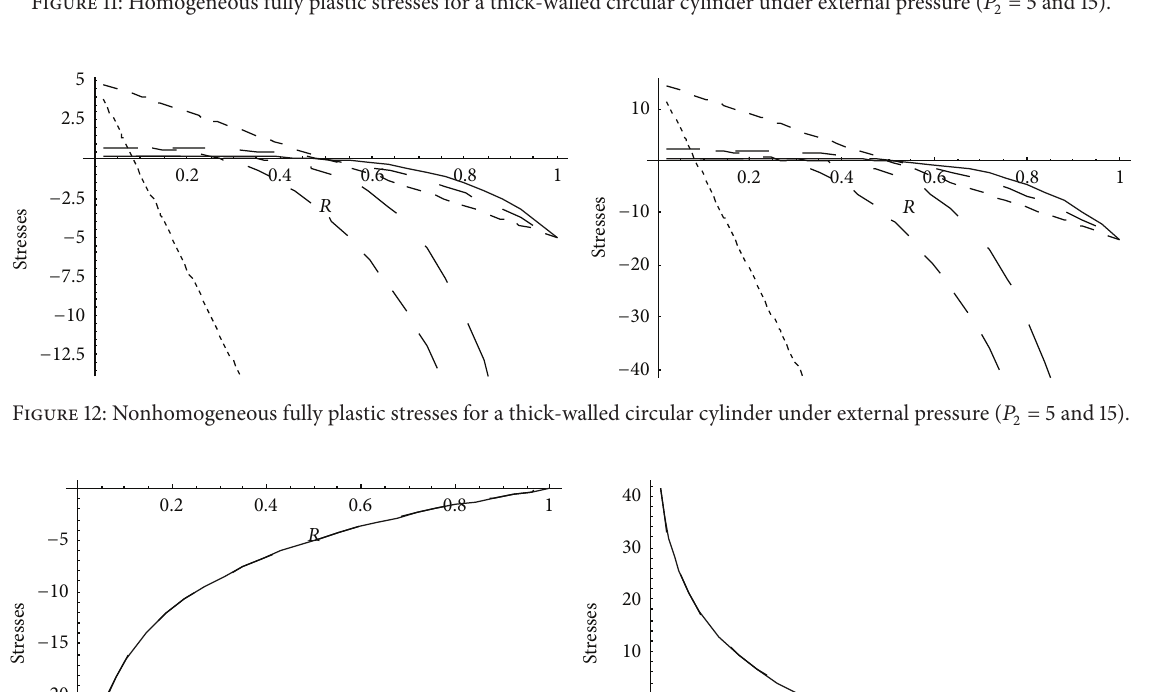
Figure 11: Homogeneous fully plastic stresses for a thick-walled circular cylinder under external pressure ( 𝑃 2 = 5 and 15).